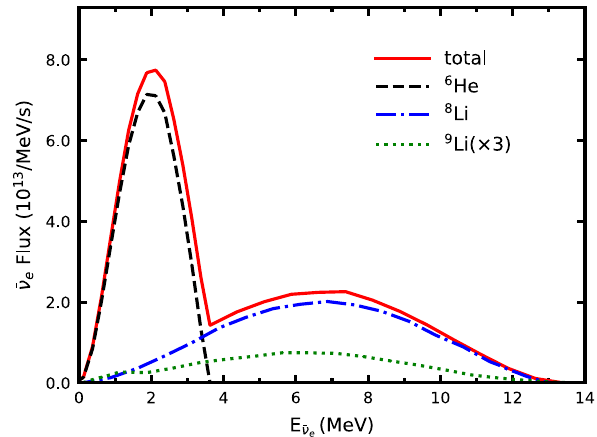
Fig. 2 The flux intensity of electron antineutrinos from the isotopes 6 He, 8 Liand 9 Li.Theirsumistheredsolidcurve.Forvisualcomparison, the 9 Li contributions are scaled by a factor of